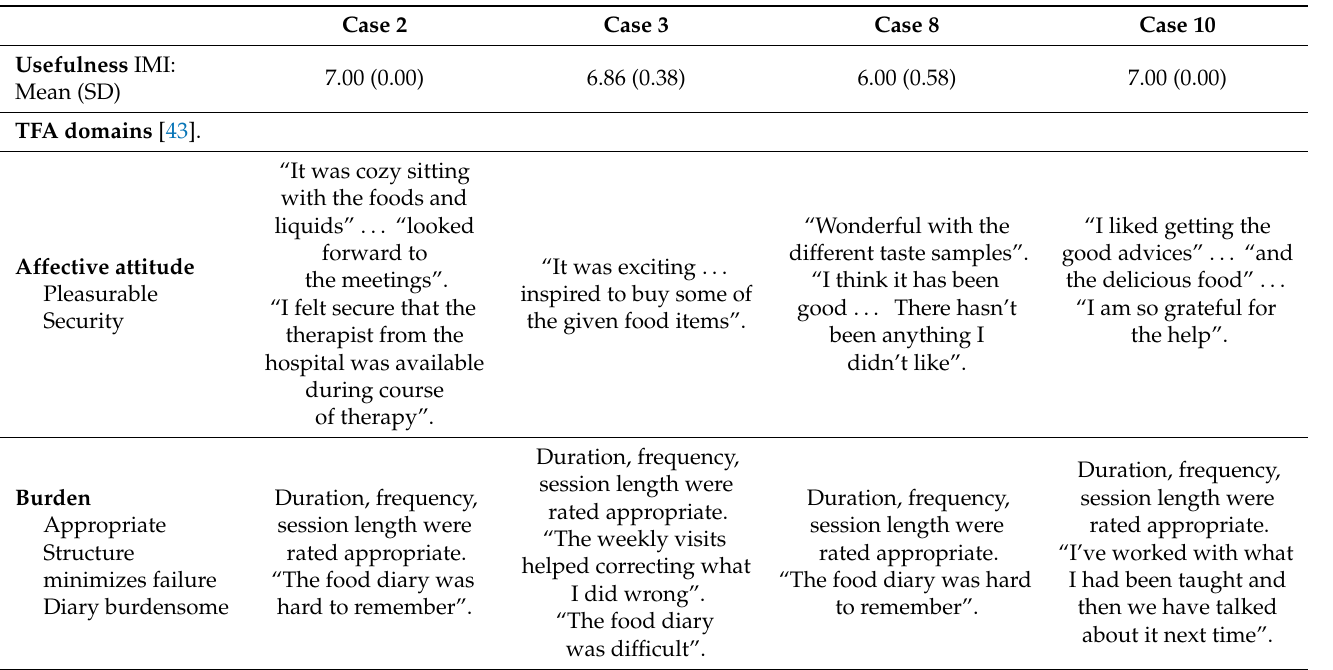
Table 5. Intervention usability and acceptability according to the Theoretical Framework of Accept- ability (TFA)